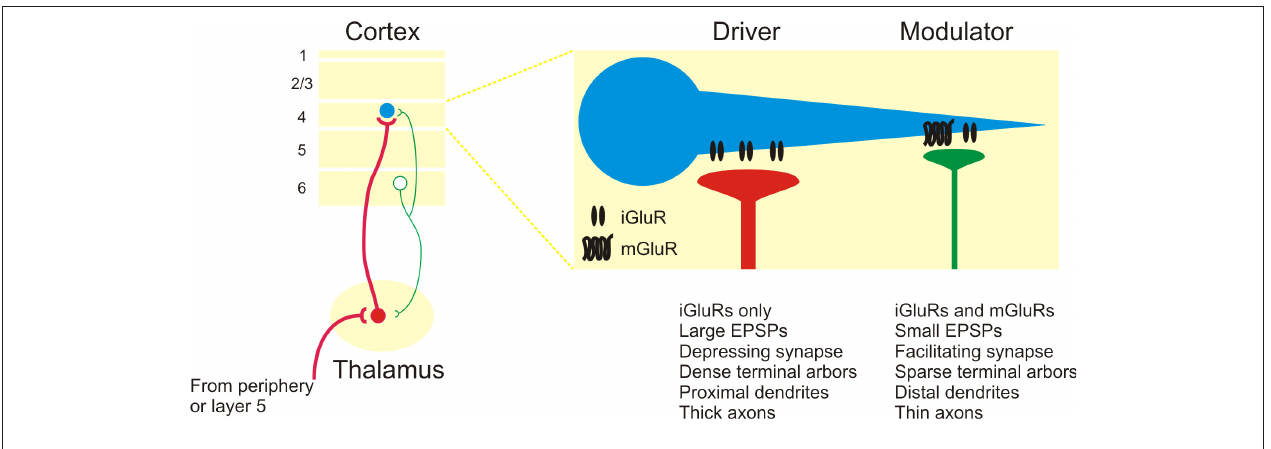
FIGURE 3 | Summary of driver and modulator inputs to layer 4 neurons in sensory neocortex. Driver inputs (red lines) to layer 4 neurons (blue circles) originate primarily from thalamic sources, while modulator inputs (green lines)